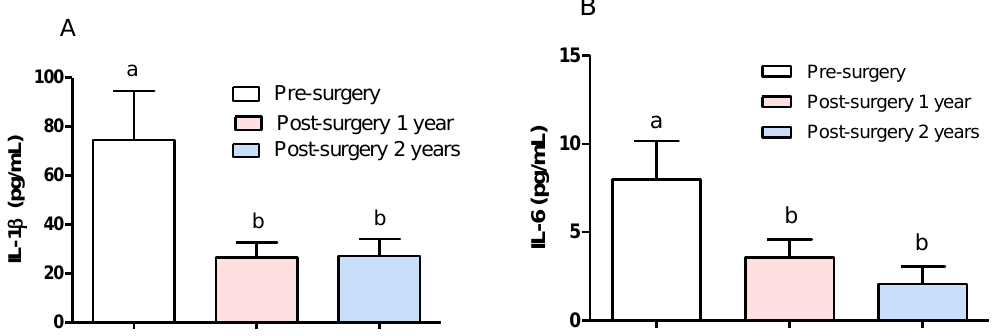
Figure 1. Comparison of IL-1 β and IL-6 concentrations before and after surgical treatment. ( A ) IL-1 β serum concentration. ( B ) IL-6 serum concentration. The bars represent the mean ± the standard error of the mean. One way ANOVA, post hoc Dunnet test, p ≤ 0.05.